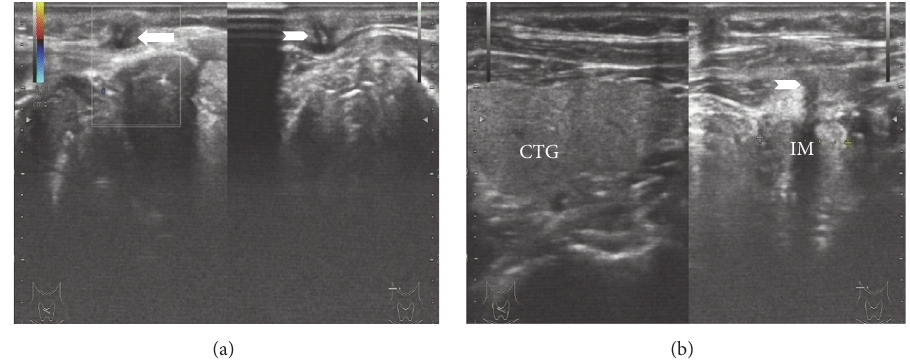
Figure 2: Transverse US image shows sinus formation. CTG: contralateral thyroid gland; IM: inflammatory mass; arrow: abscess under the skin; arrowheads: sinus.